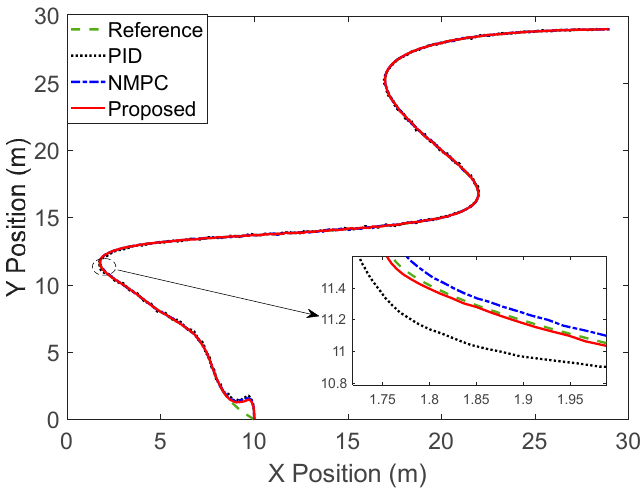
Figure 5. Tracking response of the comparison method.